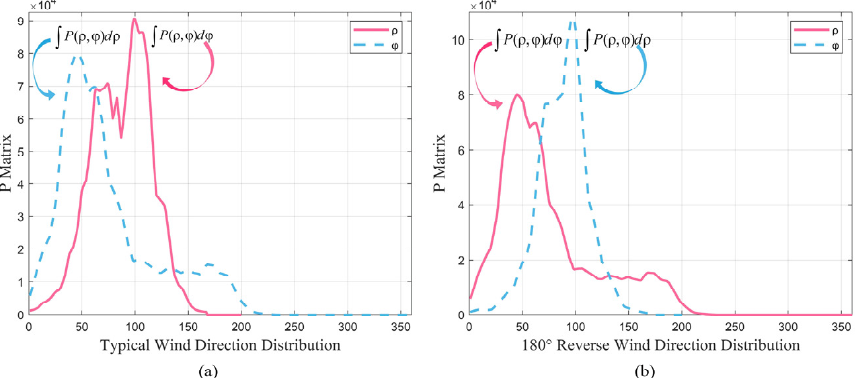
Figure 8. P matrix distribution at different angles. ( a ) Distribution of the small-angle wind direction; ( b ) distribution of the large-angle wind direction.